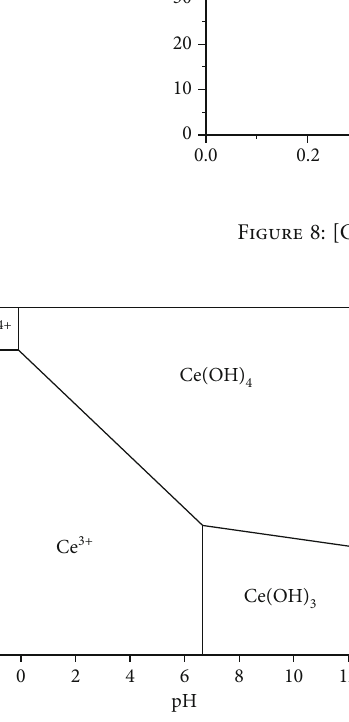
Figure 9: The potential-pH diagram of